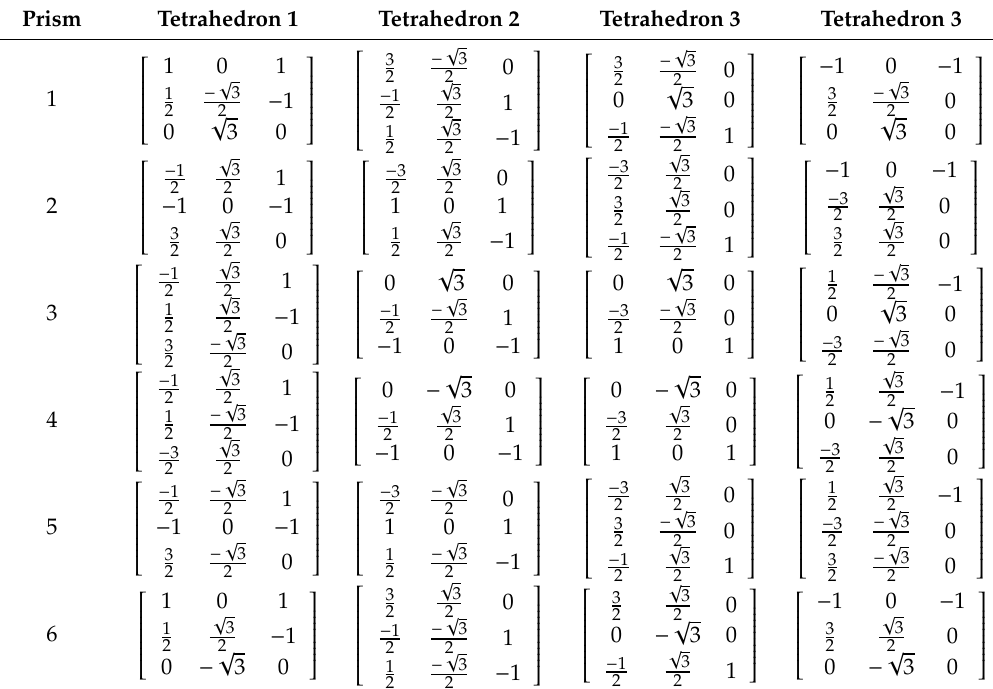
Table 4. Look up table for duty cycle